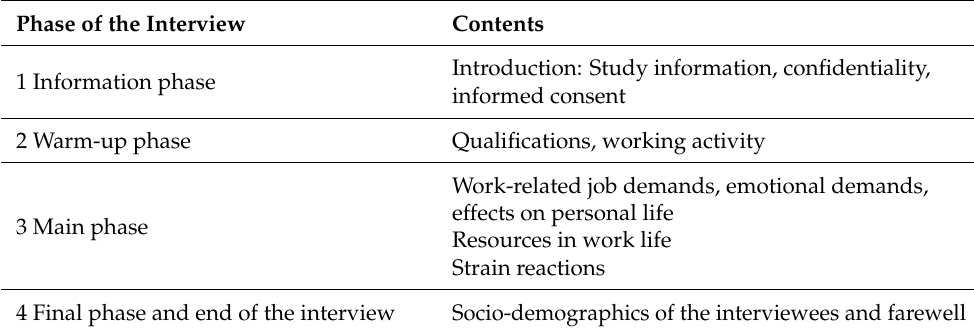
Table 1. Interview topic